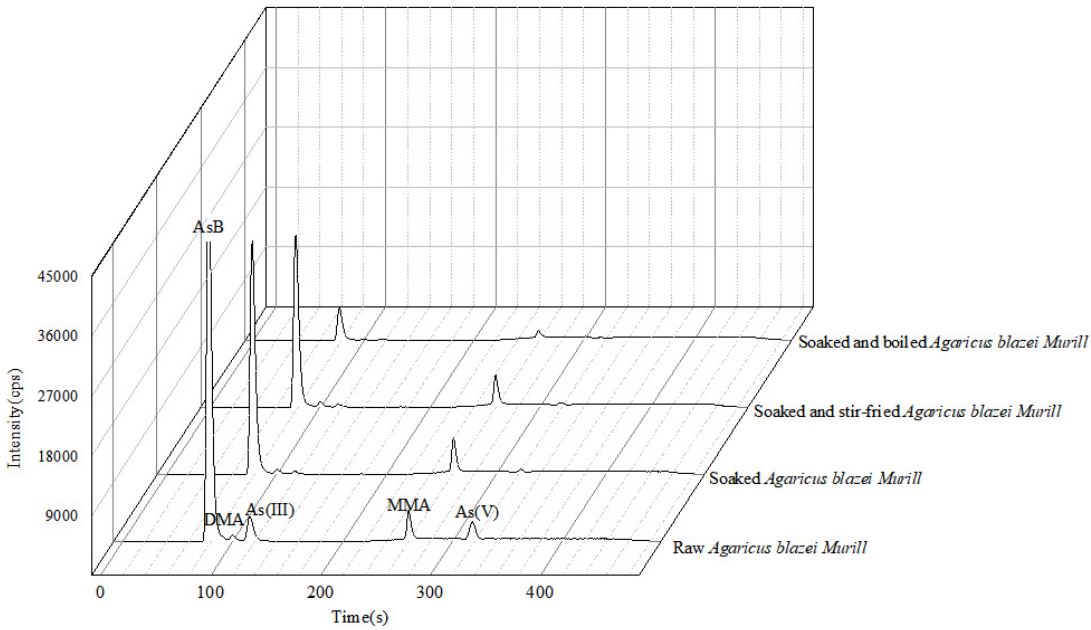
Figure 2. As speciation changes in Pleurotus citrinipileatus after different cooking methods.